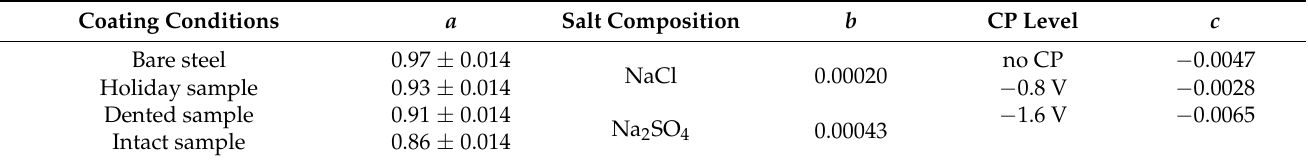
Table 4. The coefficients in the established mathematical equation.